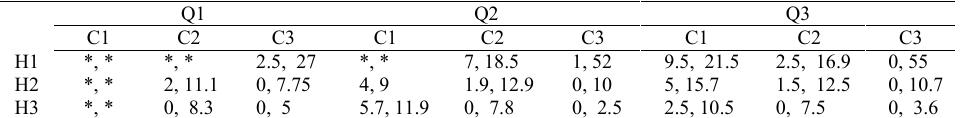
and T in all the experiments (min) i f